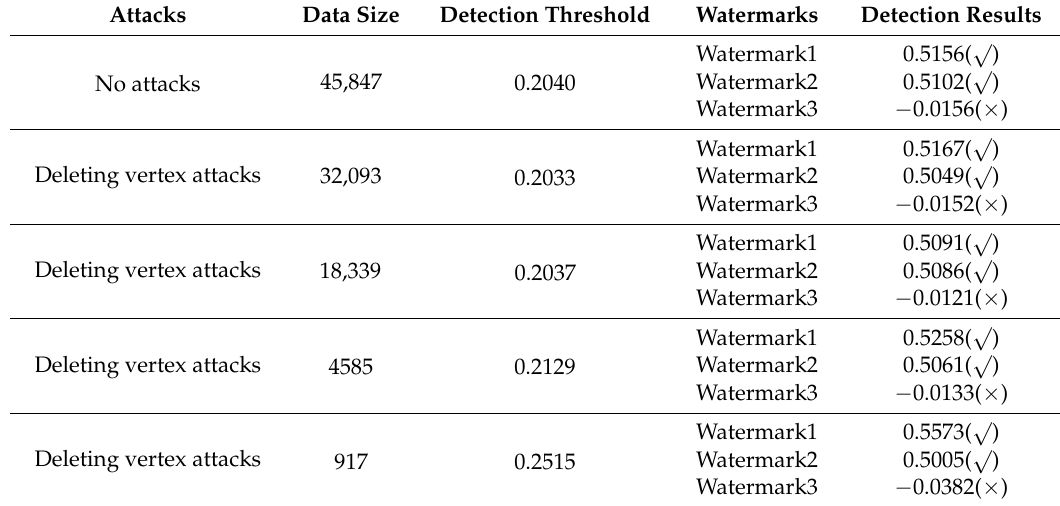
Table 1. The detection results after randomly deleting vertices of the experimental